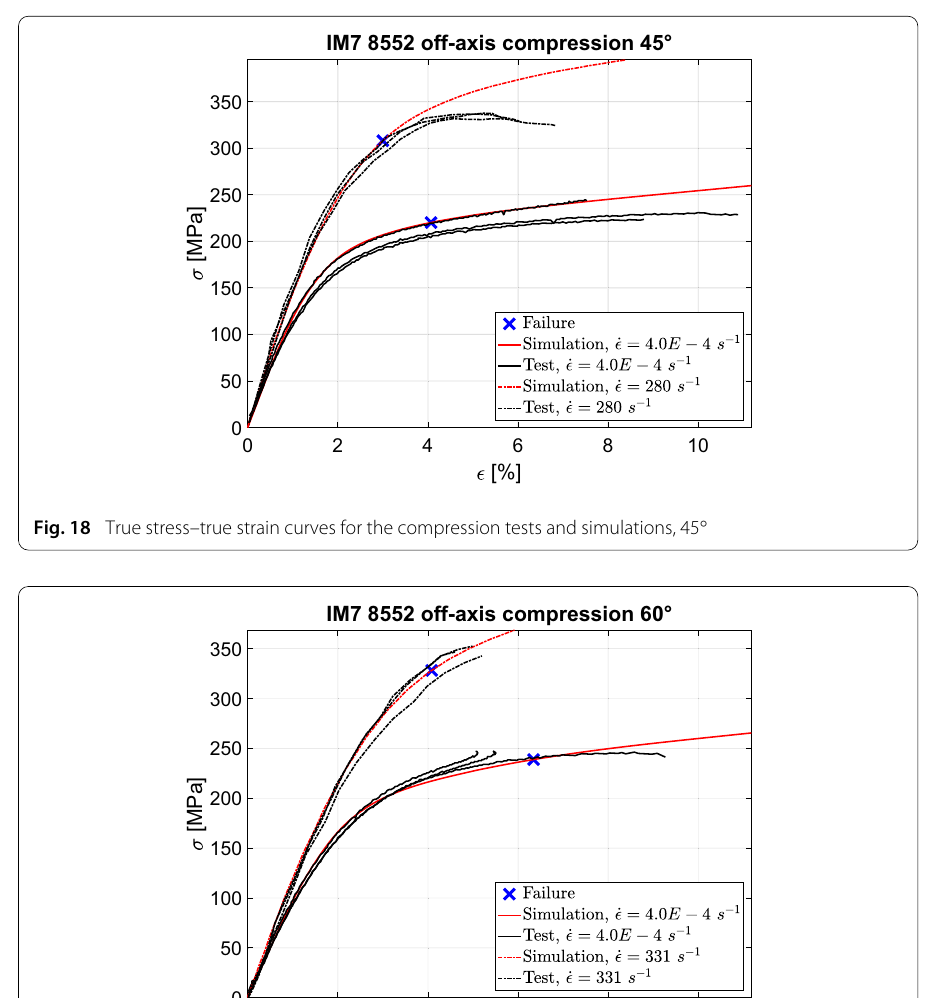
by the presented model and the scaling functions, allowing a correct prediction of the stress–strain